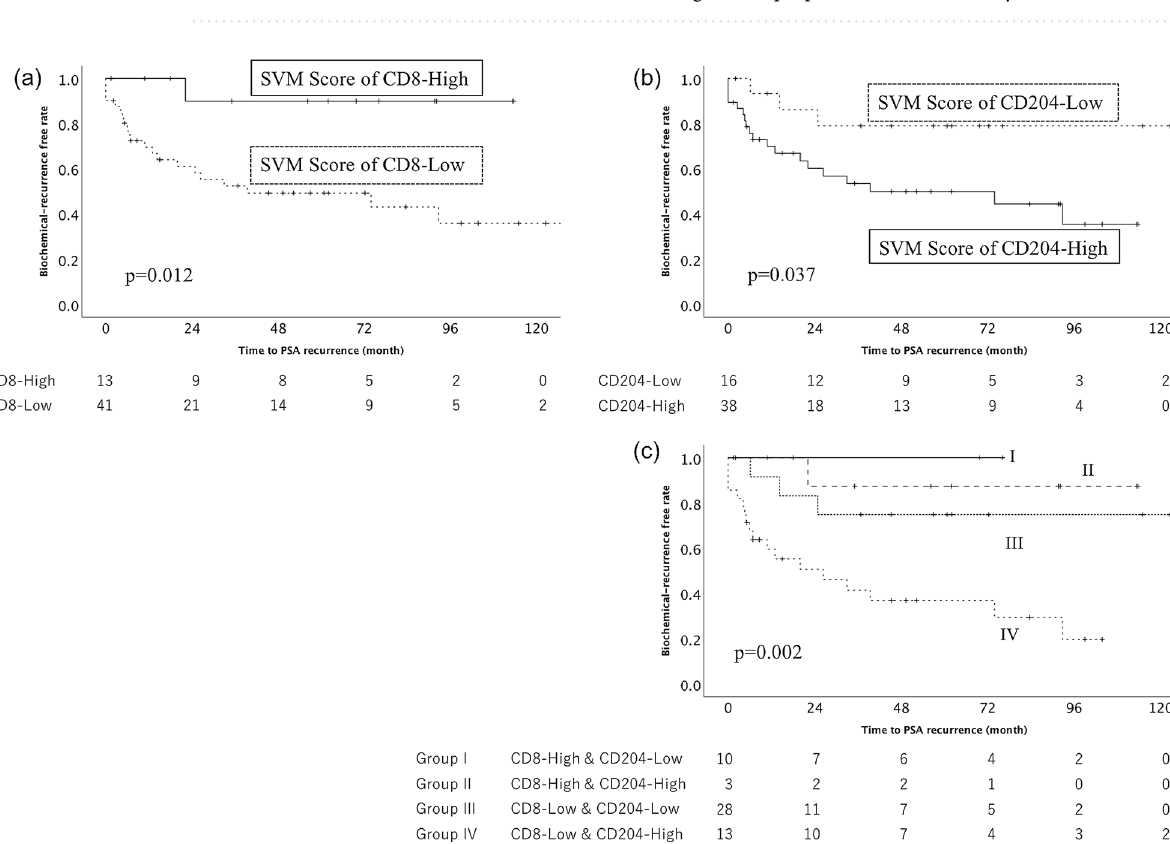
Table.2. Biochemical recurrence free survival according to Cox proportional hazards analysis.